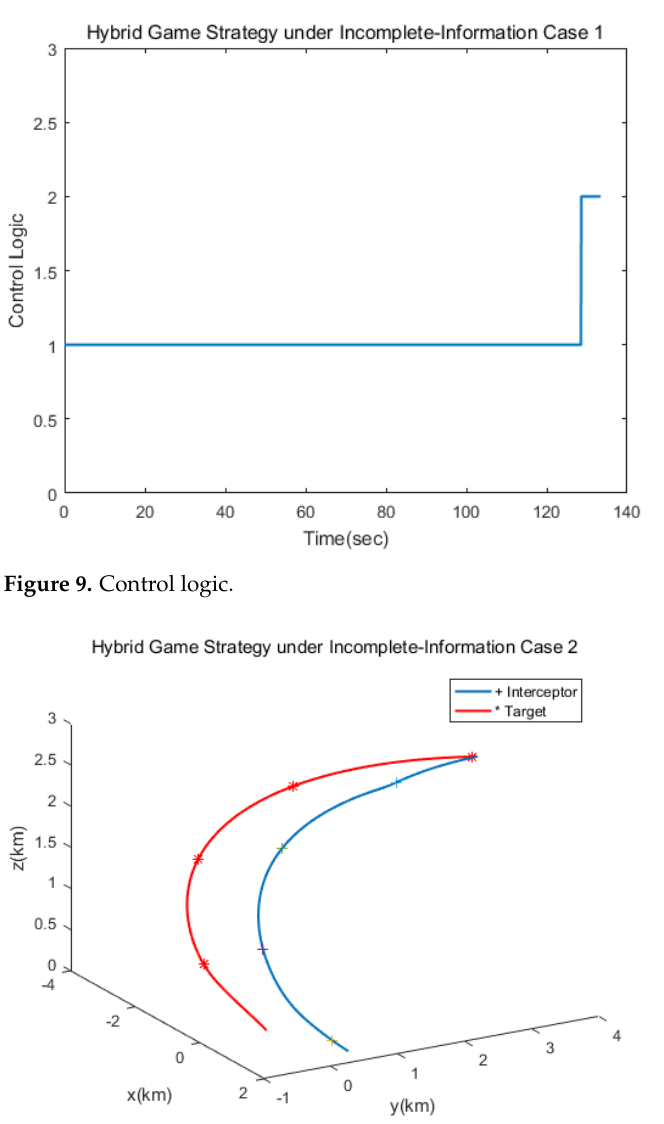
Figure 10. Spacecraft trajectories of the hybrid game strategy.